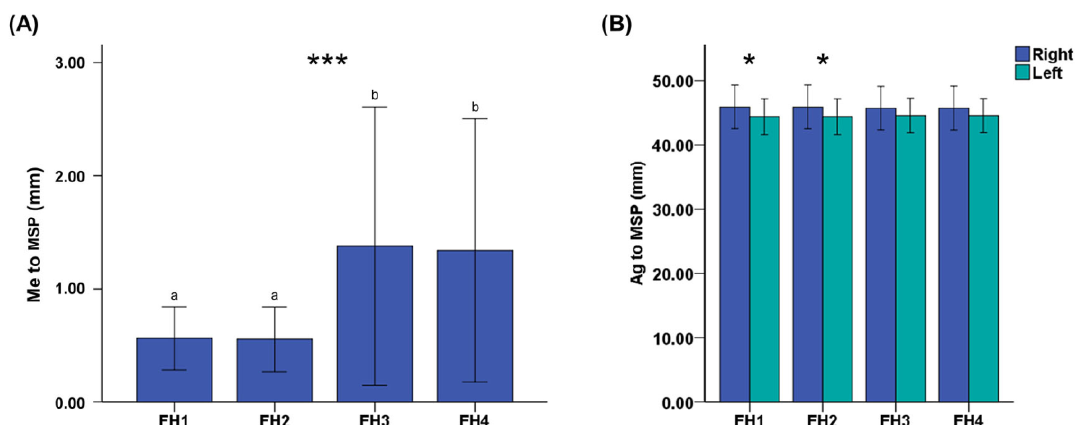
Figure 4. Influence of the different FH plane definitions on the ( A ) Me deviation and ( B ) bilateral Ag to MSP (error bars represent standard deviation). Me, menton; Ag, antegonion; MSP, midsagittal plane. Differences in the lower-case letters indicate a significant difference between the groups. * p < 0.05, *** p < 0.001.